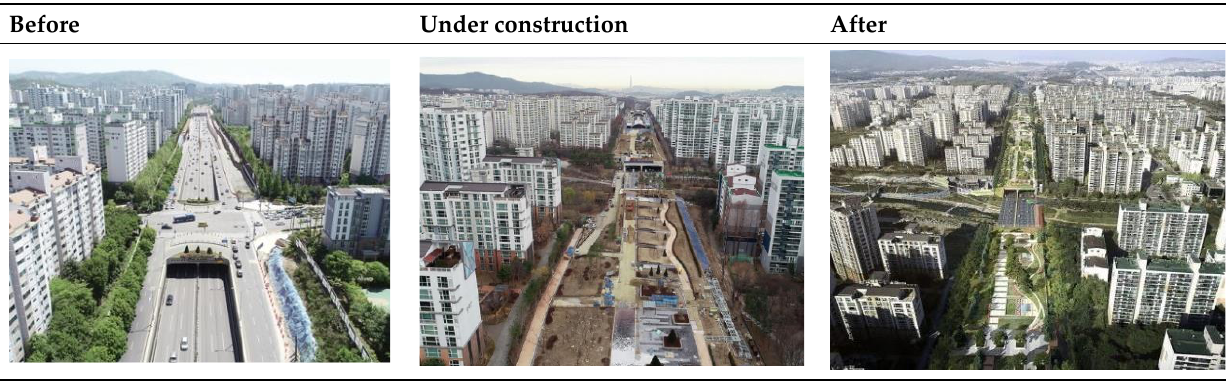
Figure 2. Bundang – Suseo Expressway upper park development process. Figure 2. Bundang–Suseo Expressway upper park development